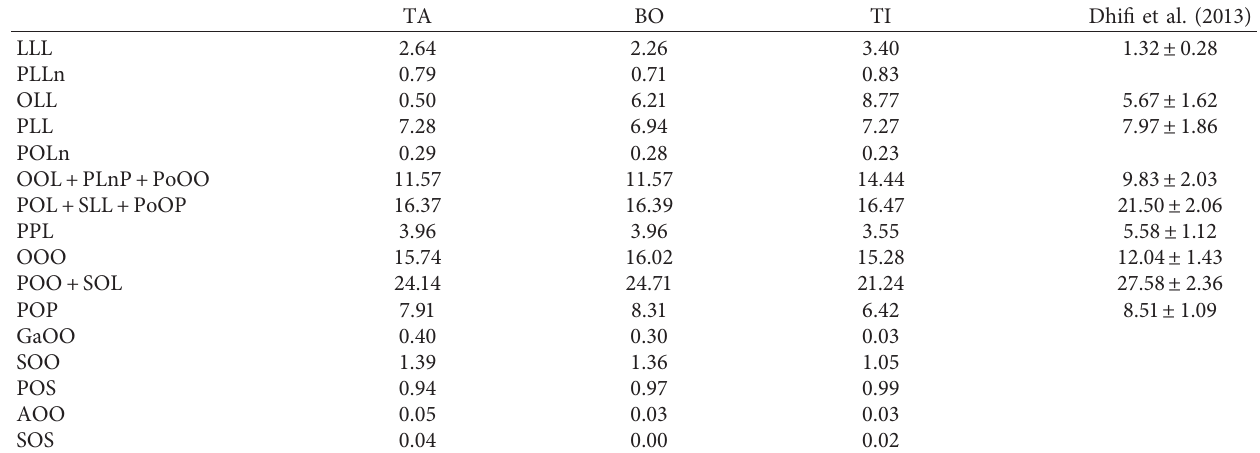
Table 3: Triglyceride composition of the seed oil of Pistacia lentiscus by HPLC (%).